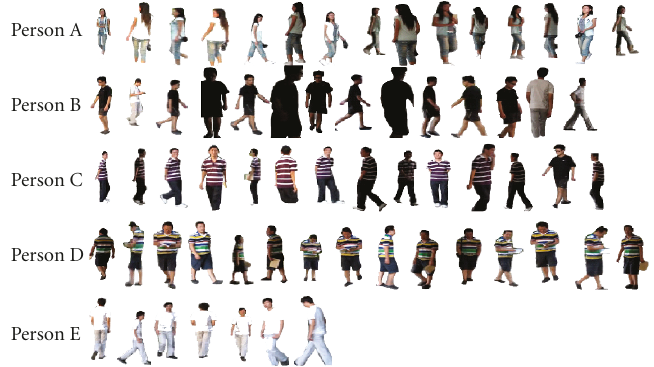
Figure 21: Trajectories recovered by EM with backward appr.II inference initialized by K-means clustering. Table 4: Running time of inference algorithms under di ff erent number of observations (s). No.